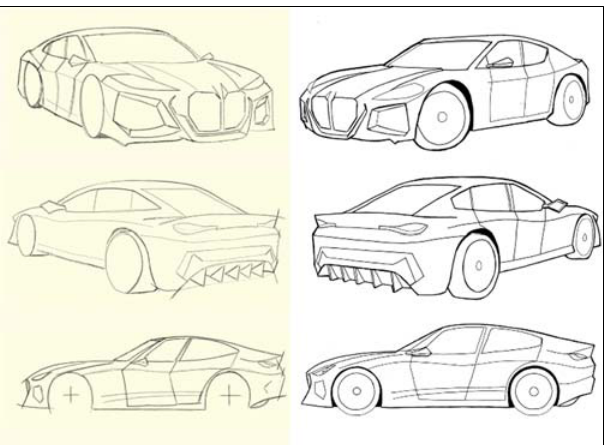
Figure 7. Sketches of the nature